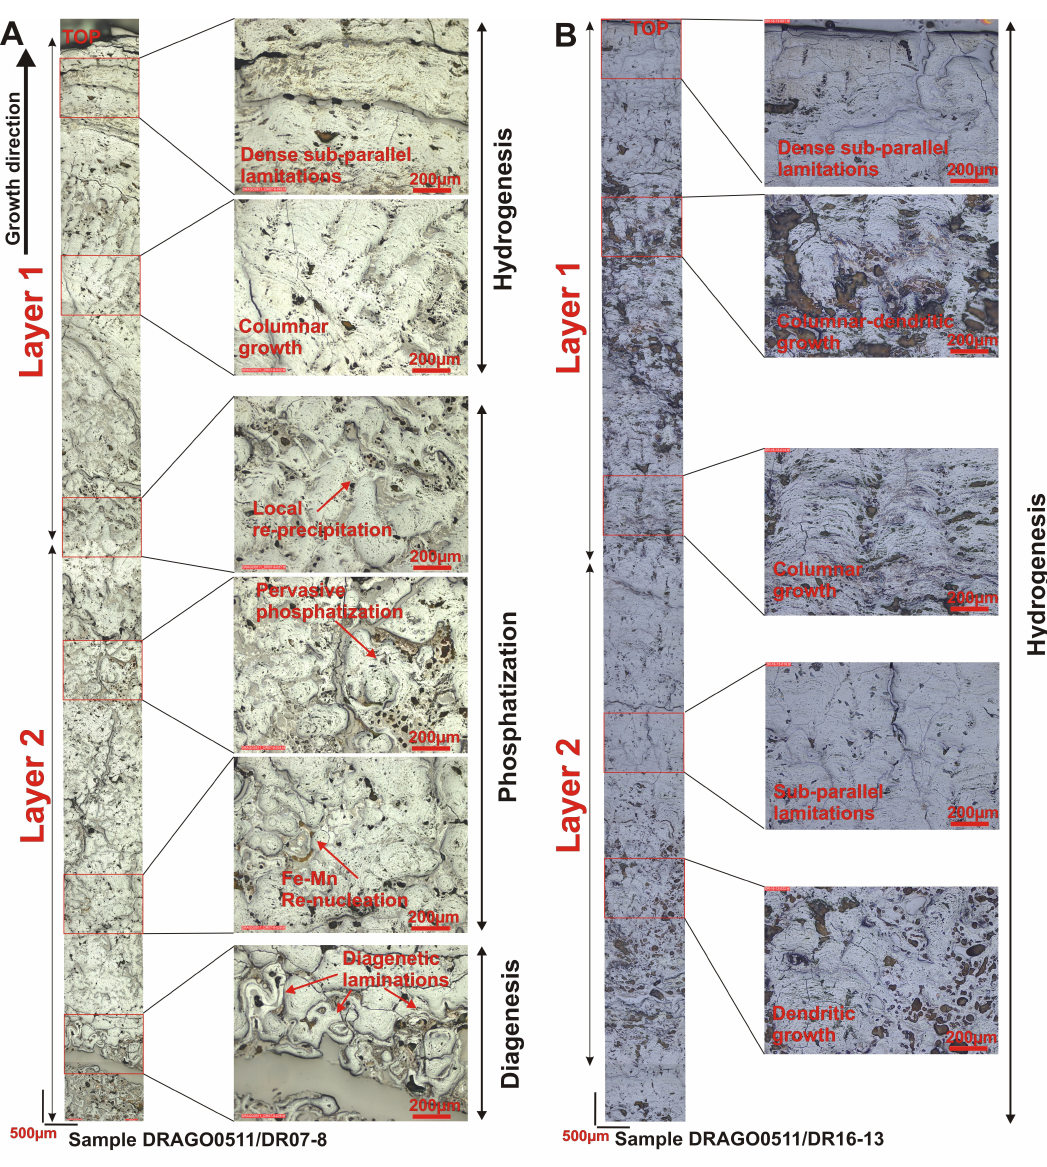
Figure 4. Representative sections under the petrographic microscope in continuous profiles. ( A ) profile section of crust DR07-8 and ( B ) profile section of crust DR16-13. Zoomed-in views represent specific interesting areas in which structures have been differentiated: (1) dense sub-parallel, (2) dendritic-mottled or (3) columnar growth. Several bright laminations (diagenesis) have also been recognised together with the presence of pervasive phosphatization bounded with dissolution and re-nucleation of Fe–Mn